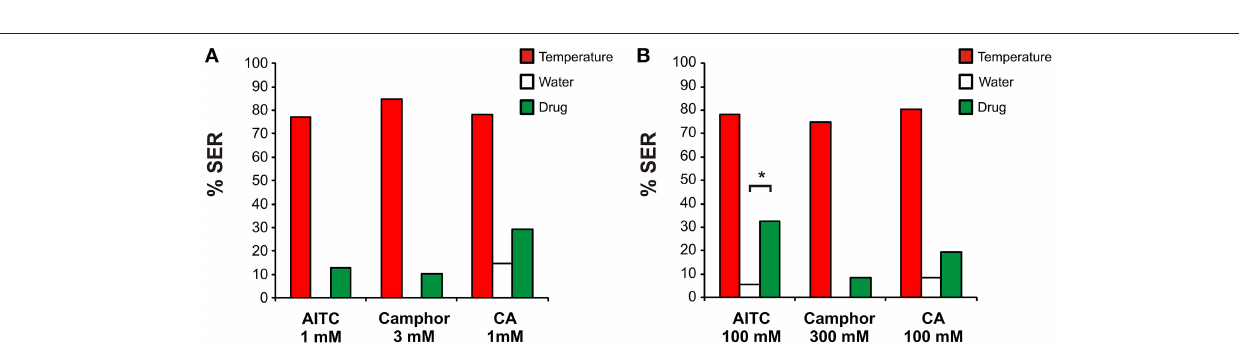
FIGURE 5 | Effect of topical application of HsTRPA activators on sting extension responses. The bees’ mouthparts were stimulated with AITC (allyl isothiocyanate), CA (cinnamaldehyde) or camphor at two concentrations, (A) 1–3mM or (B) 100–300mM (all drugs in green). A thermal stimulation (red) or a water control (white) were used as controls. Only 100mM AITC led to significant SER compared to the water control ( * p < α corr = 0.025